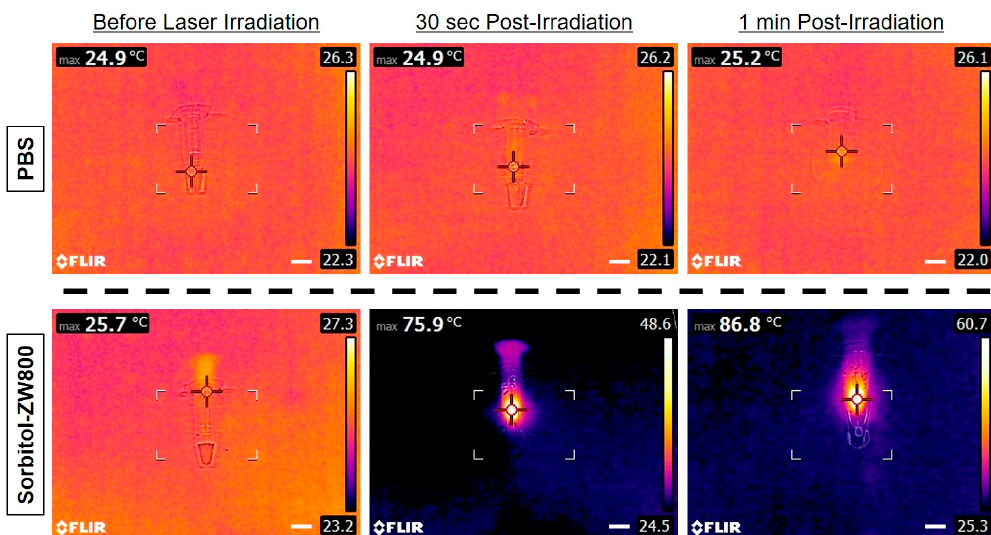
Figure 2. In vitro photothermal images of the sorbitol–ZW800 solution (10 µg/100 µL in PBS; 100 µM concentration is equivalent to 0.4 mg/kg as a single dose) and PBS alone (100 µL) exposed to the 808 nm laser (1.1 W/cm 2 ) for 1 min. The maximum temperature was automatically recorded with an infrared thermal camera as a function of irradiation time. Scale bars = 1 cm.